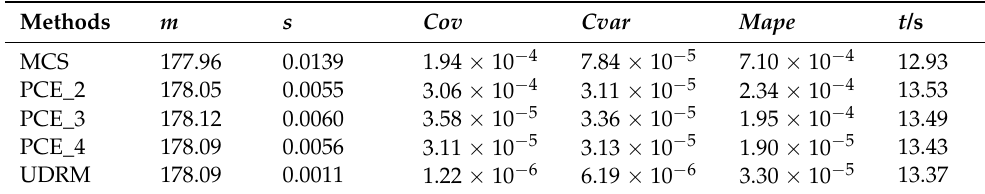
Table 8. Evaluation table of different UQ methods under 50% uncertainty of the cable length under short-circuit